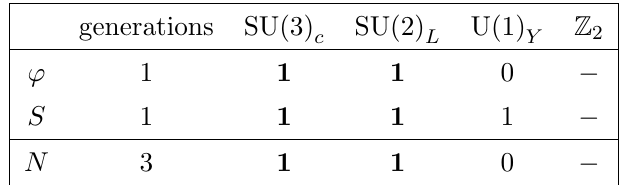
Figure 10 . Same as (cid:12)gure 8 but for IH for the neutrino masses. Bluish points are excluded due to perturbativity arguments.